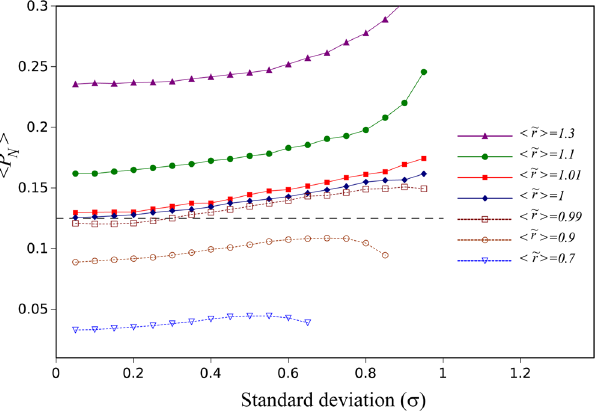
Figure 3. The average mutant fixation probability as a function of the standard deviation of the bimodal fitness distribution ( N = 8) for different average fitness values of the mutants, with 〈 r 〉 = 1 and σ σ = ~ (equalstandard − deviations), in a death birth Moran process . Normally, a neutral mutant will have 〈 P (dashed horizontal line). Mutants with the mean fitness less than that of the wild type behave as if they are